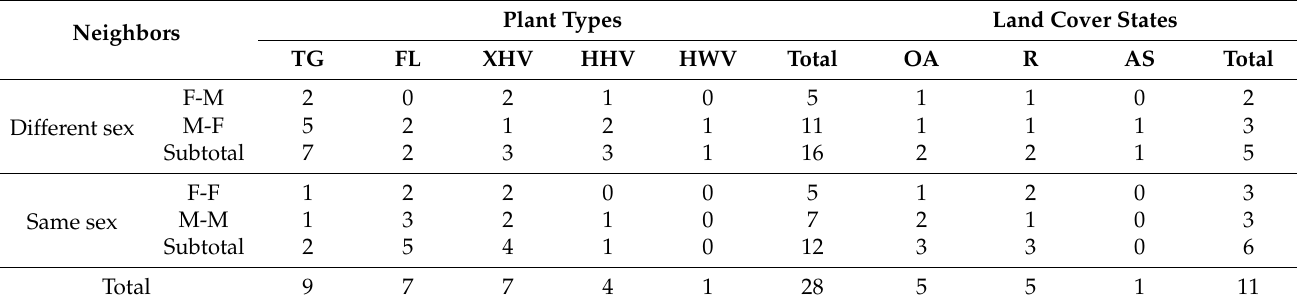
Table 1. Co-occurrence of nutria individuals in association with plant types and land cover states, according to a visual inspection of the Geo-SOM component maps (all observed cases reported regardless of individuals).